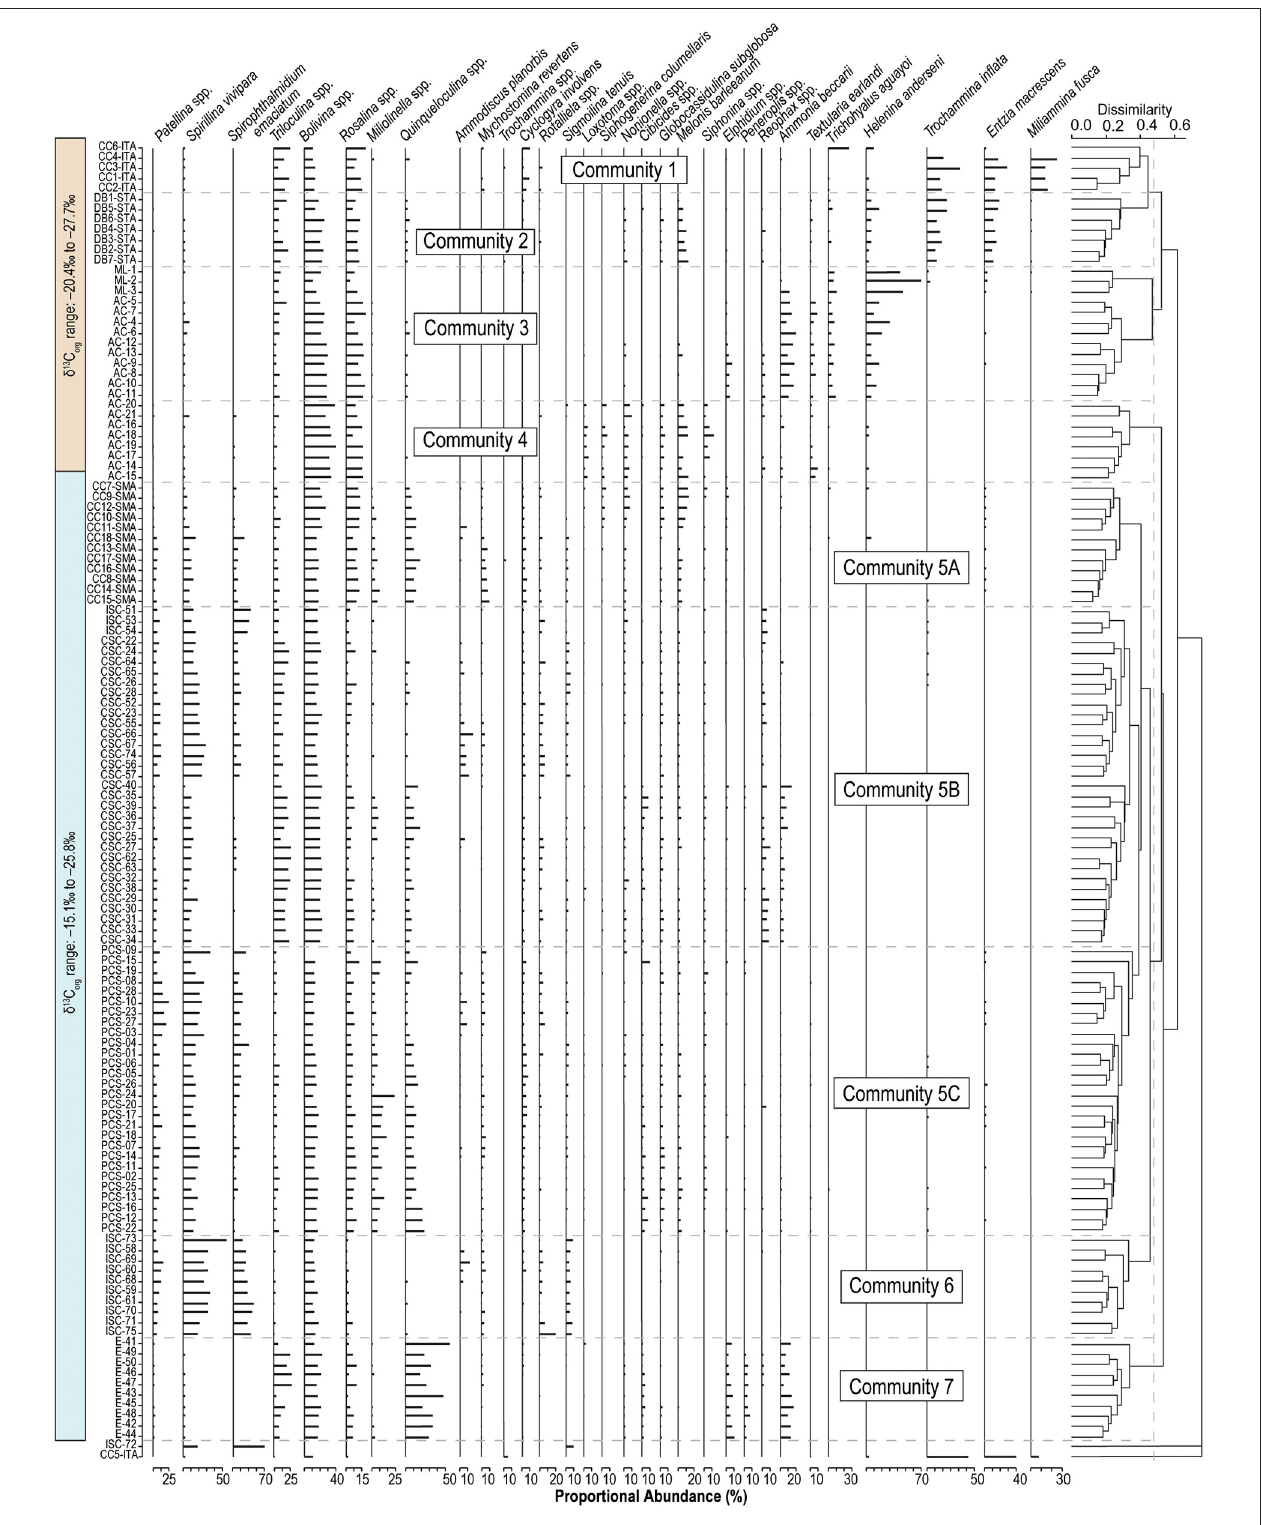
FIGURE 4 | Benthic foraminiferal communities in Palm Cave, Green Bay, Cow Cave, and Deep Blue as defined by groupings in a dendrogram produced from Q-mode cluster analysis. A 7-cluster (dissimilarity 0.44) or a 9-cluster division (dissimilarity 0.36) of the dendrogram correlates well with the measured environmental variables. Only taxa with > 5% in at least one sample are shown to emphasize significant